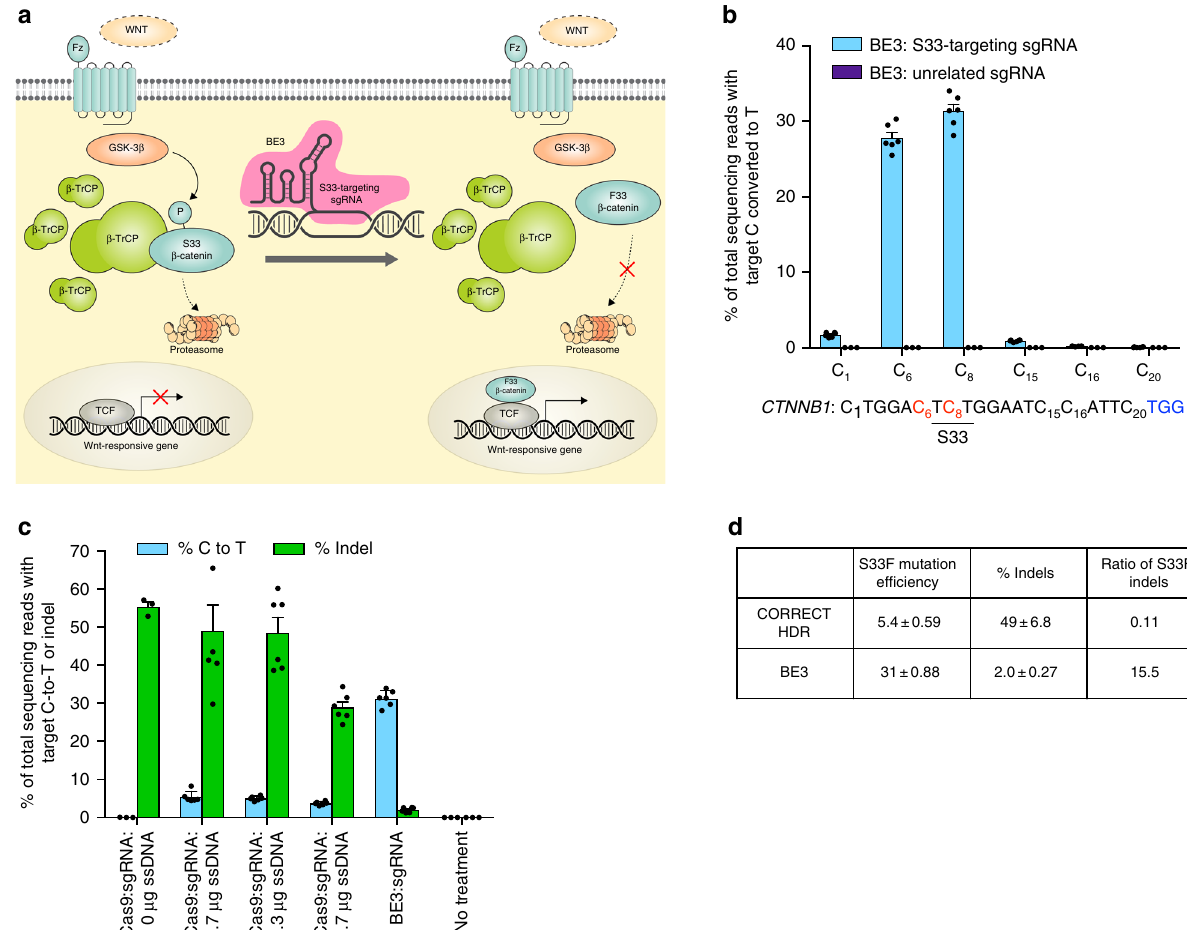
Fig. 1 Base editing strategy and comparison of HDR and base editing following plasmid delivery. a Schematic representation of the canonical Wnt pathway and a base editing strategy to stabilize β -catenin. In the absence of Wnt signaling, β -catenin is phosphorylated at Ser 33 by GSK-3 β and degraded in a phosphorylation-dependent manner. Base editing with BE3 precisely mutates the Ser 33 codon to instead encode Phe, which cannot be phosphorylated. The resulting S33F β -catenin has an extended half-life and can activate target gene transcription by binding with TCF/LEF transcription factors. b HEK293T cells were transfected with plasmids expressing BE3 and S33-targeting sgRNA, or BE3 and an unrelated sgRNA. The percentage of total sequencing reads (with no enrichment for transfected cells) with C8 converted to T8 (resulting in the S33F mutation) was measured with high-throughput sequencing (HTS). c Plasmid delivery of Cas9 and BE3 (750 ng) with S33-targeting sgRNA (250 ng) into HEK293T cells using 1.5 µ L of Lipofectamine 2000 per well of a 48-well plate. C-to-T conversion ef fi ciency and d product selectivity ratio (desired S33F mutation: undesired indel ratio) resulting from the best-performing ratio of Cas9:sgRNA:ssDNA template and BE3. Values and error bars re fl ect mean ± S.E.M. of three biological replicates performed